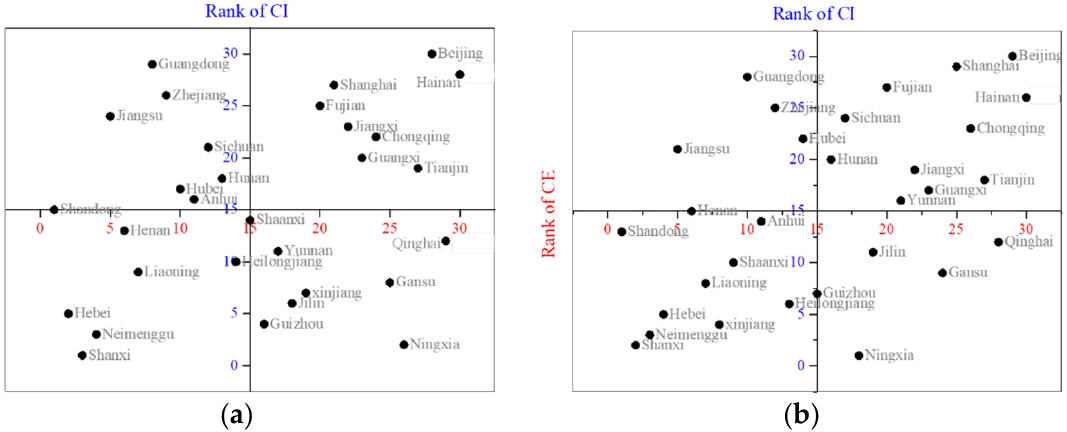
Figure 3. ( a ) The ranking of carbon emission and intensity of 30 provinces and cities before trading policy (2005–2013). ( b ) The ranking of carbon emission and intensity of 30 provinces and cities after trading policy (2014–2019). Table 6. Regional division and the related provinces or cities.